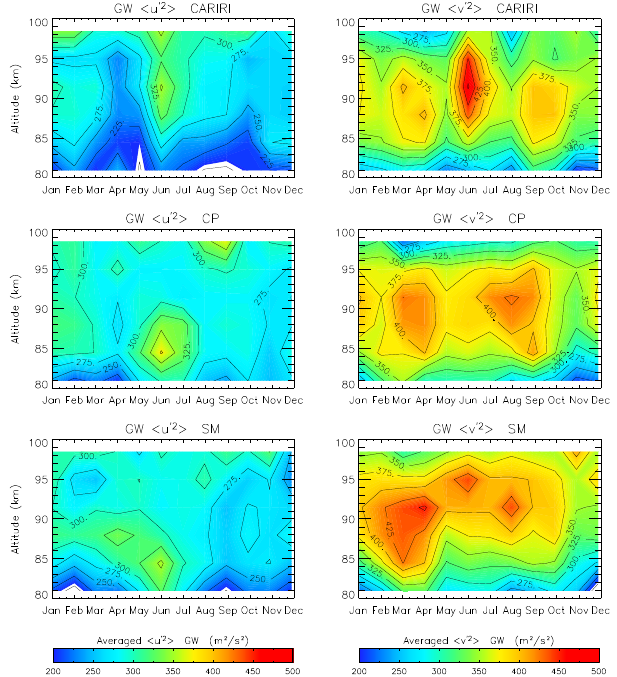
Figure 8. Averaged GW variances throughout the entire available data series: zonal (left) and meridional (right) components. Each contour corresponds to 25m 2 s − 2 . The top panels are the results for São João do Cariri (Cariri, low latitude), the center panels are the results for Cachoeira Paulista (CP, mid–low latitude), and the bottom panels are the results for Santa Maria (SM, middle latitude).